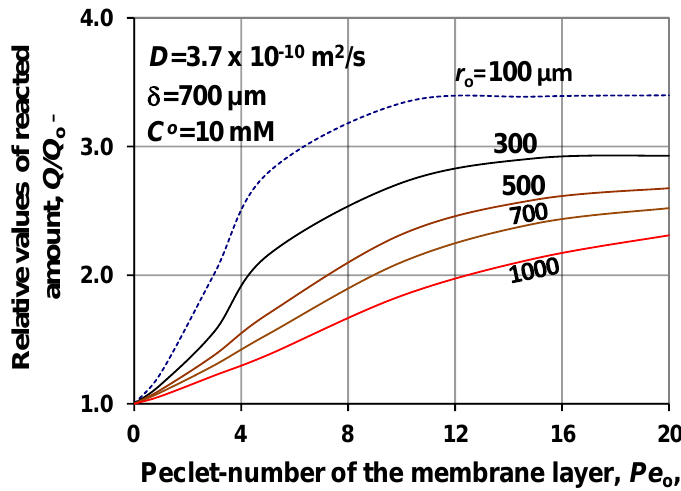
Figure 12. Specific reacted amount of substrate as a function of the inlet Péclet number, at various numbers of membrane inlet radius; Q o belongs its value without convective flow, at Pe o = 0. ( D = 3.7 × 10 − 10 m 2 /s; δ = 700 μm; C O = 10 mM; N = 1000).